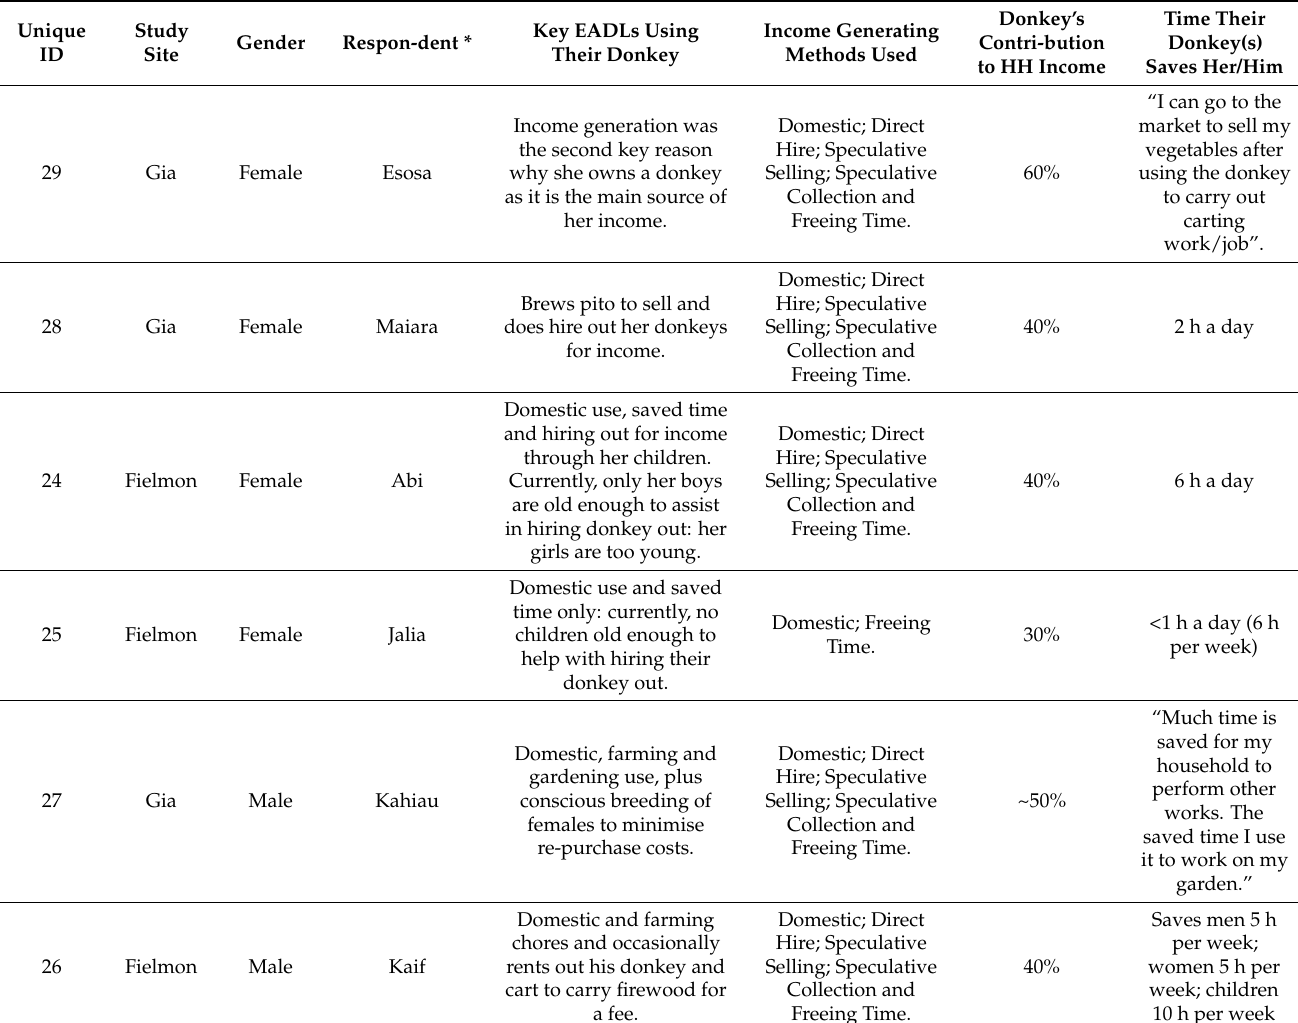
Table 3. Donkeys’ contribution to household income in northern